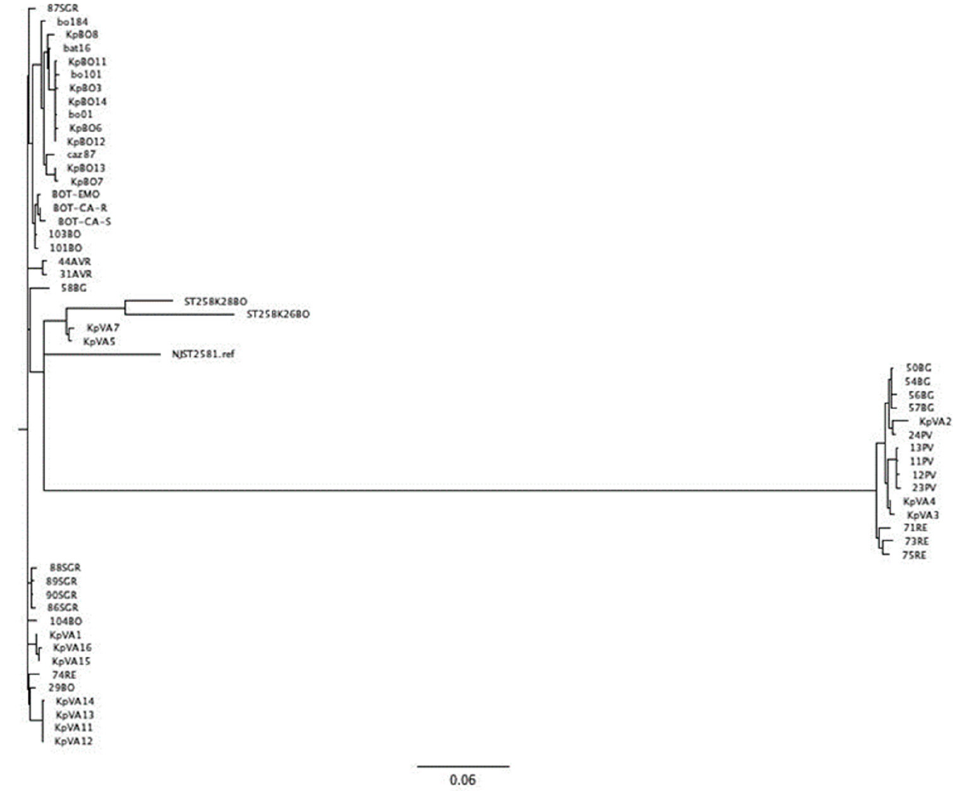
Figure 1. Phylogenetic tree analysis of KPC-Kp Italian isolates and strains included in this study.